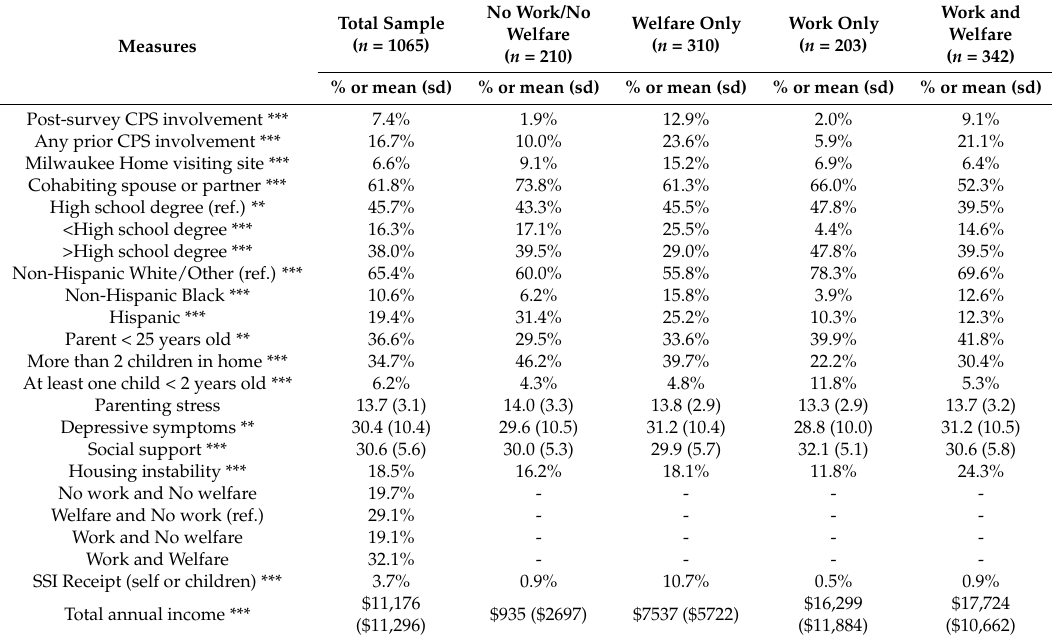
Table 1. Sample characteristics by work and welfare